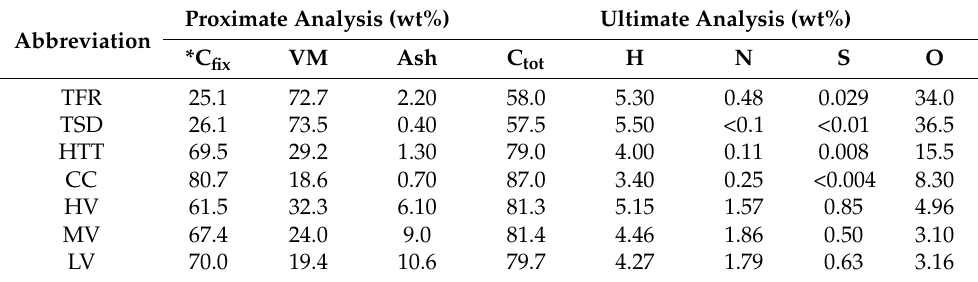
Table 2. Proximate and ultimate analysis for carbonaceous materials (dry base).